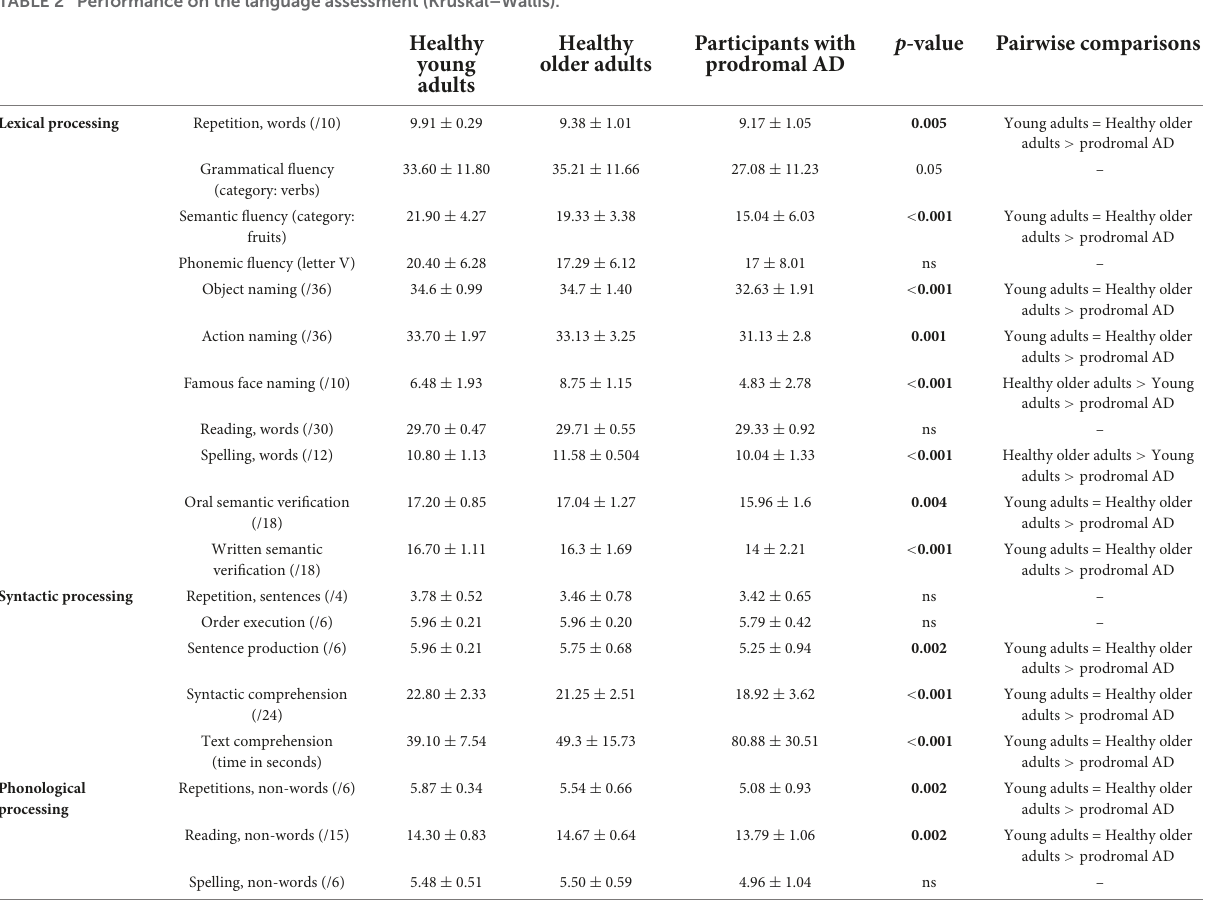
TABLE 2 Performance on the language assessment (Kruskal–Wallis).